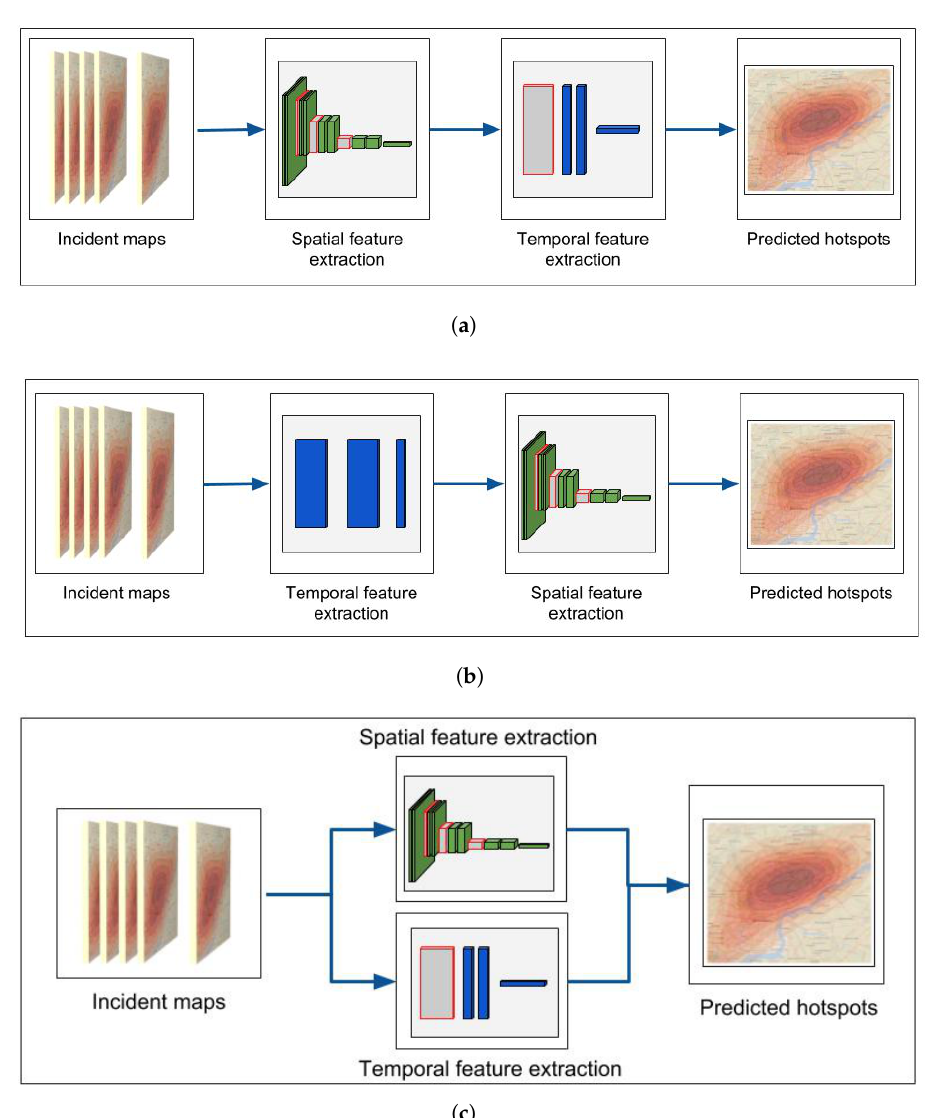
Figure 1. Overview of the sequence of feature extraction: ( a ) the spatial features first then the temporal (SFTT), ( b ) the temporal features first then the spatial (TFTS) and ( c ) spatial and temporal features in two parallel branches